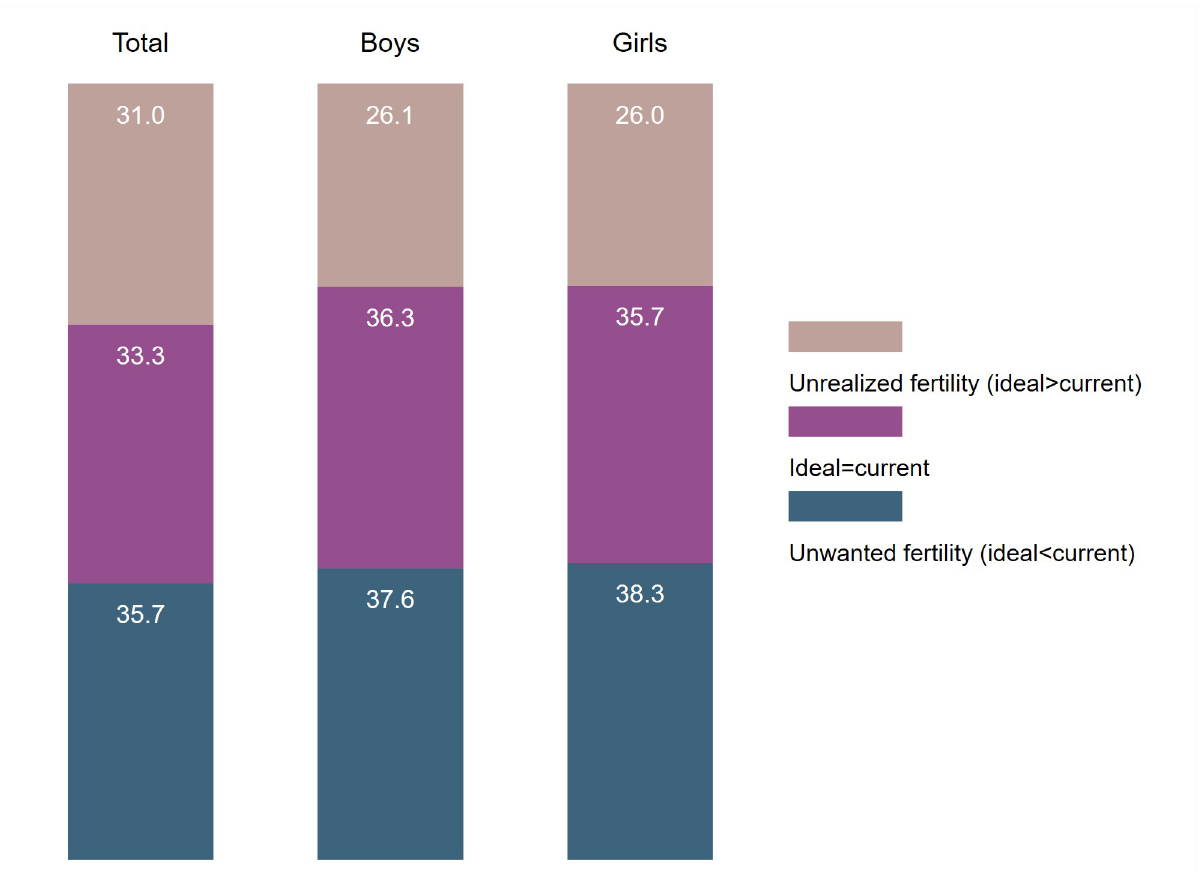
Fig 4. Distribution of ideal minus current number of children among women age 44–48, South and Southeast Asia.